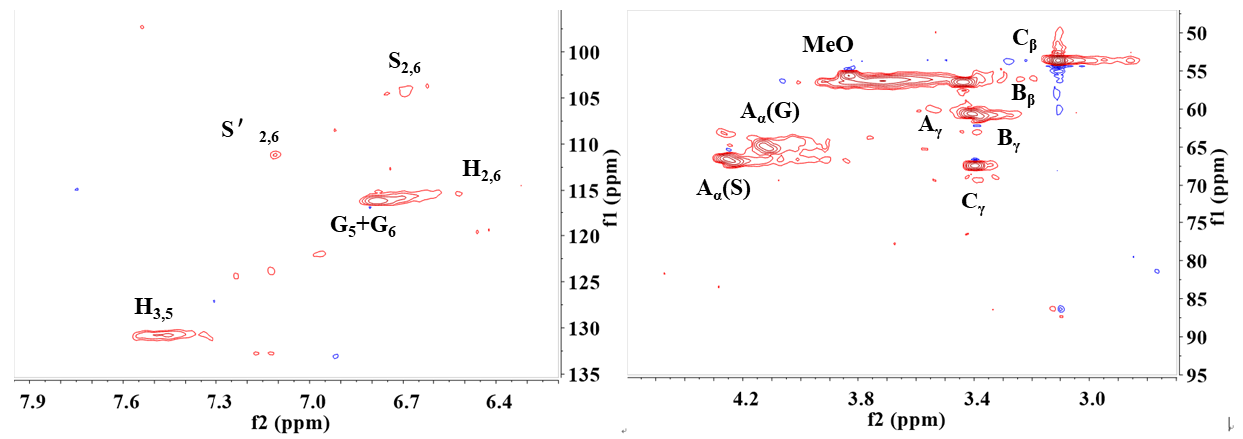
Figure 10. H–13C heteronuclear single quantum correlation (HSQC) NMR spectroscopy of Figure 10. H−13C heteronuclear single quantum correlation (HSQC) NMR spectroscopy of Re -L.